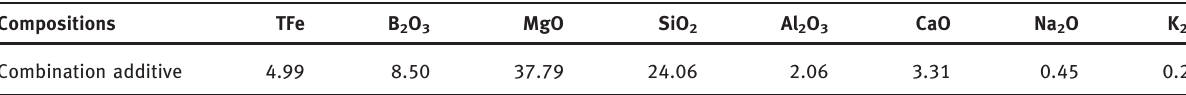
Table 4: Chemical compositions of combination boron mud additive/%.